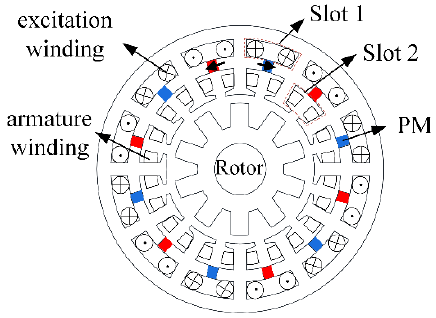
Figure 1. The geometry of the proposed HEDSGSW.